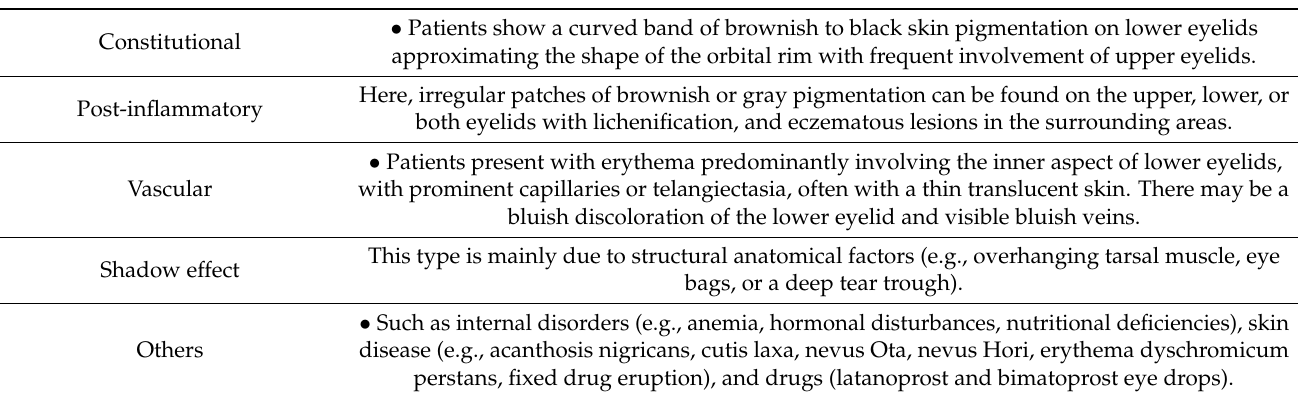
Table 2. Severity grading of POH according to Sheth et al. (2014)